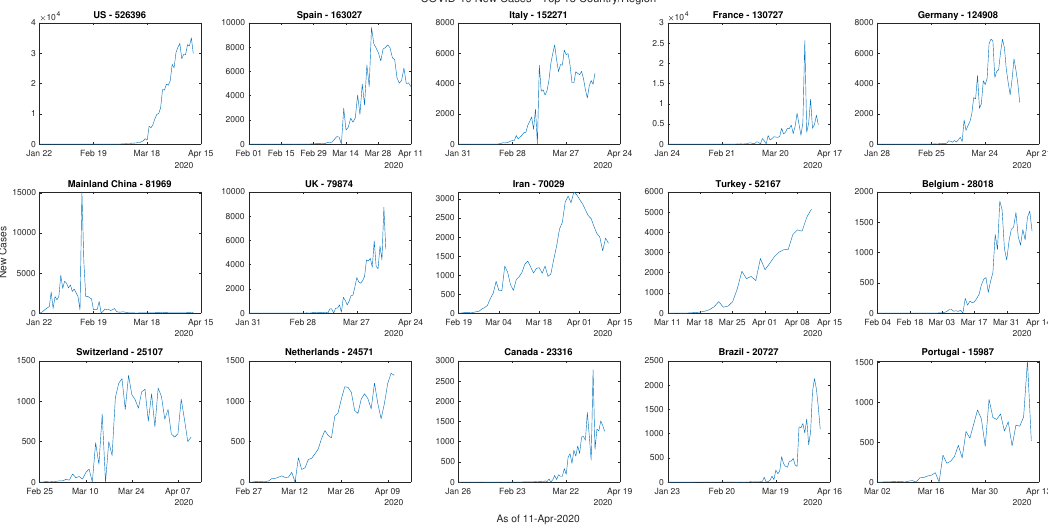
Figure 12. World map: reported infectious as of 30 March 2020. COVID-19 New Cases - Top 15 Country/Region